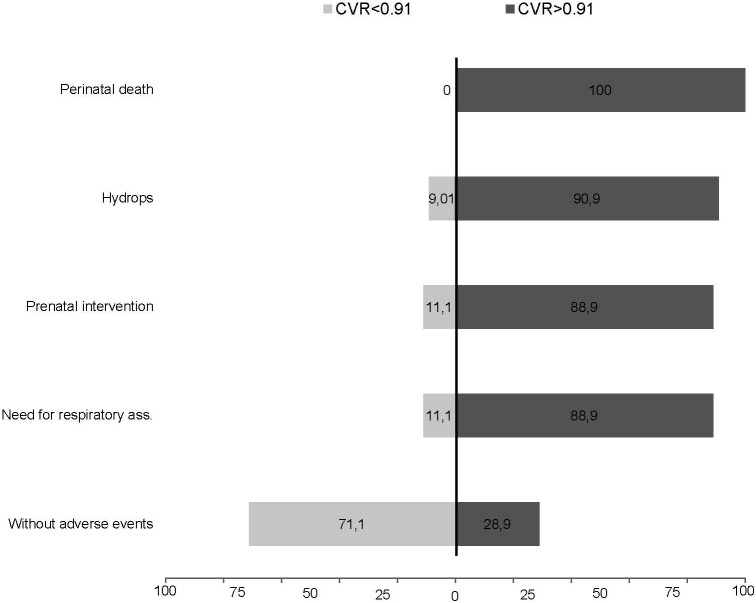
Detectionrate in % of adverse events (perinatal death, hydrops, prenatal intervention or need for respiratory assistance) at a cutoff of 0.91 CPAM volume ratio (CVR) in comparison to fetuses without adverse events.